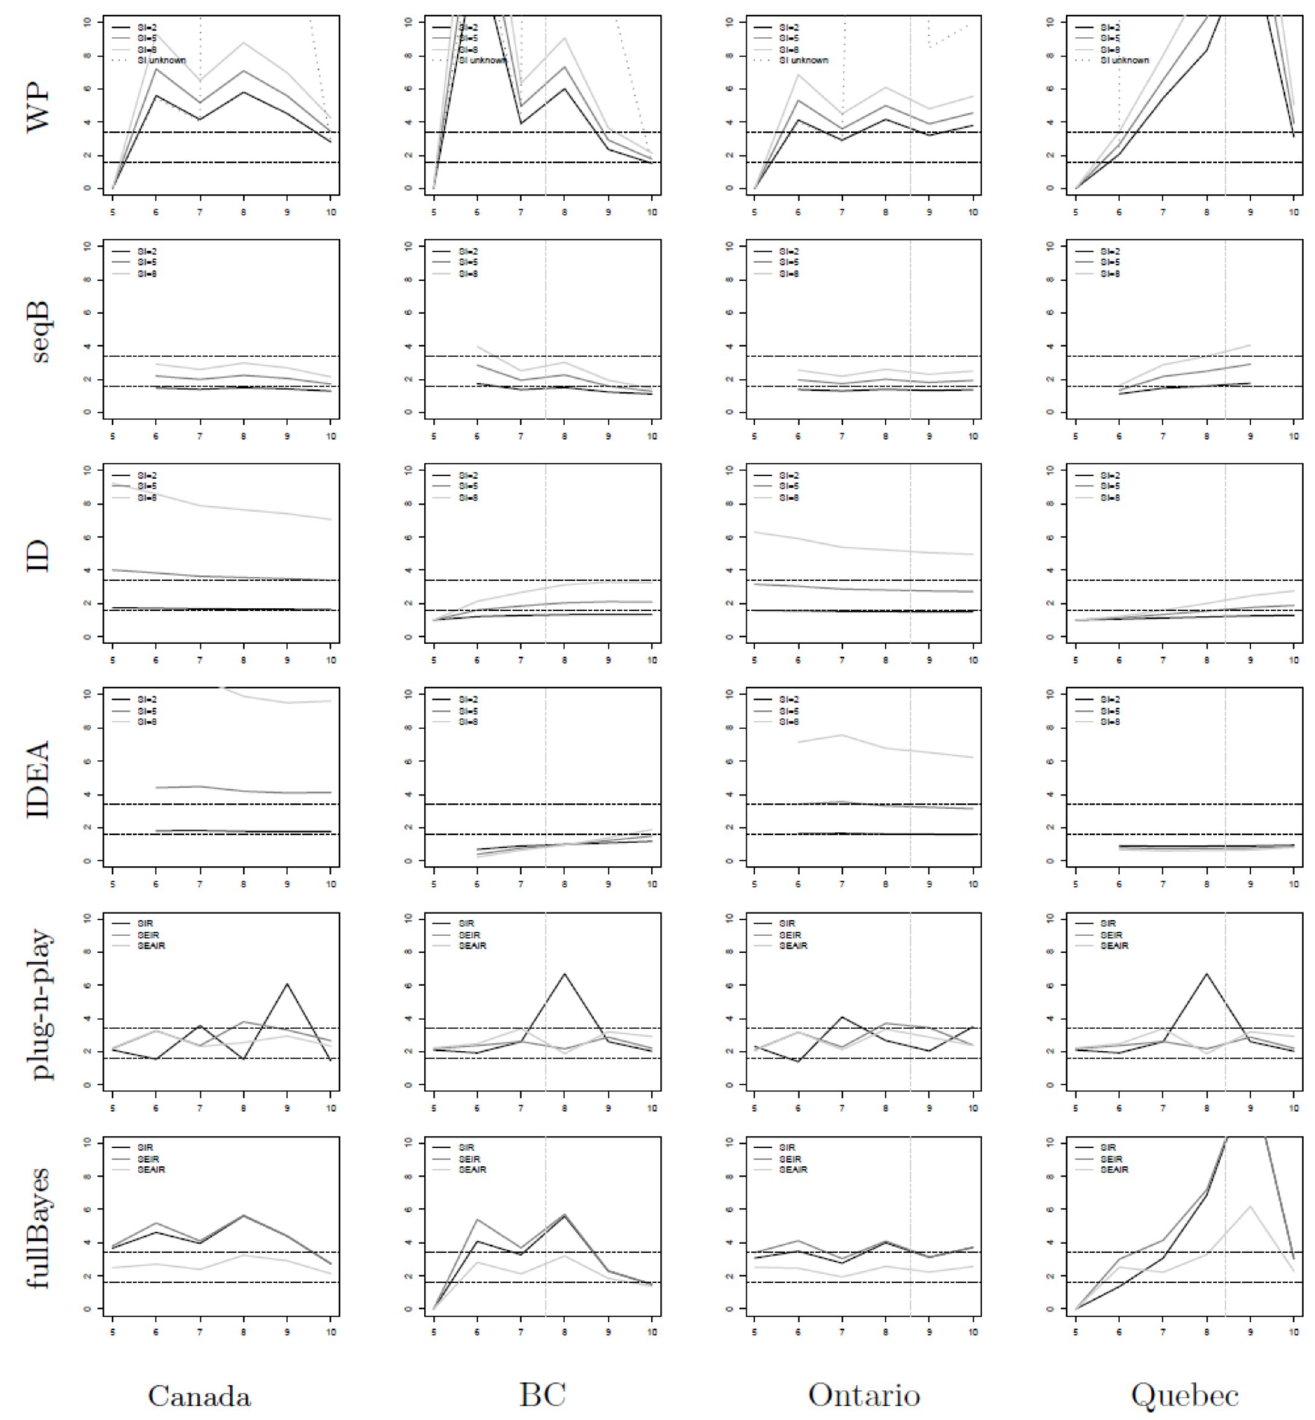
Fig 6. R 0 estimators ( y -axis) for COVID-19 data in Canada. Data from [52]. The x -axis shows time in weeks where t = 0 denotes January 25, 2020—the date of the first known case in Canada [51]. The vertical gray line shows the date of lockdown for each of the provinces (there was no national lockdown date) [51]; while the horizontal lines denote estimates of R 0 from reference [3]. The provinces of BC (second column), Ontario (third column), and Quebec (last column) are studied, as well as the entire nation (first column). The WP, seqB, ID and IDEA methods are applied using assumed known serial intervals of 2, 5, and 8 days.